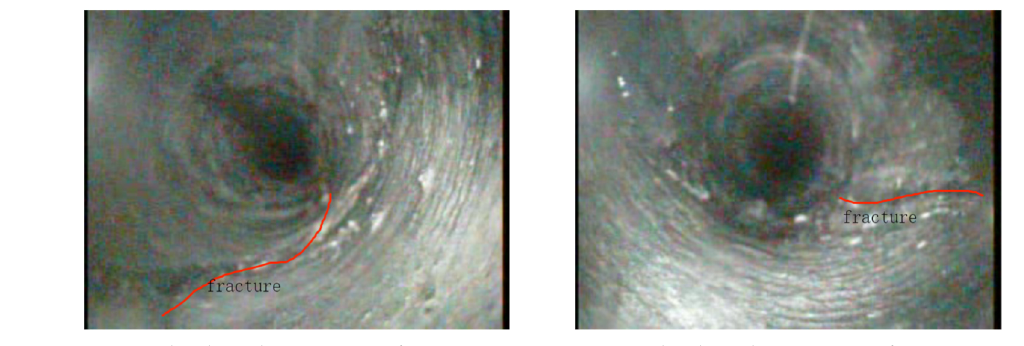
Figure 5. Peeping results of strata after mining in No. 5 hole 15 m away from the working face. By collecting and analyzing the fissure positions of the pre-mining and post-mining boreholes, the stratum where the fissures are located can be calculated according to the elevation angle and depth of the boreholes. Usually affected by mining, the fissure zone will form a fracture surface and fracture space at a layer of a certain height. After the actual measurement, it is concluded that the height of the fissure surface in the caving zone of the #15 coal seam is 8.24~13.49 m, and the height of the fissure surface in the fissure zone is 19.19~27.46 m (see Table 2). Table 2. Fracture height calculation table.